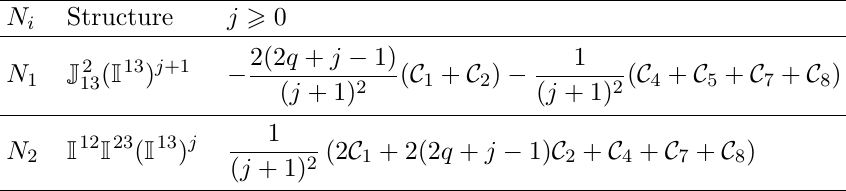
( QO ) J ( QO ) when QO h i